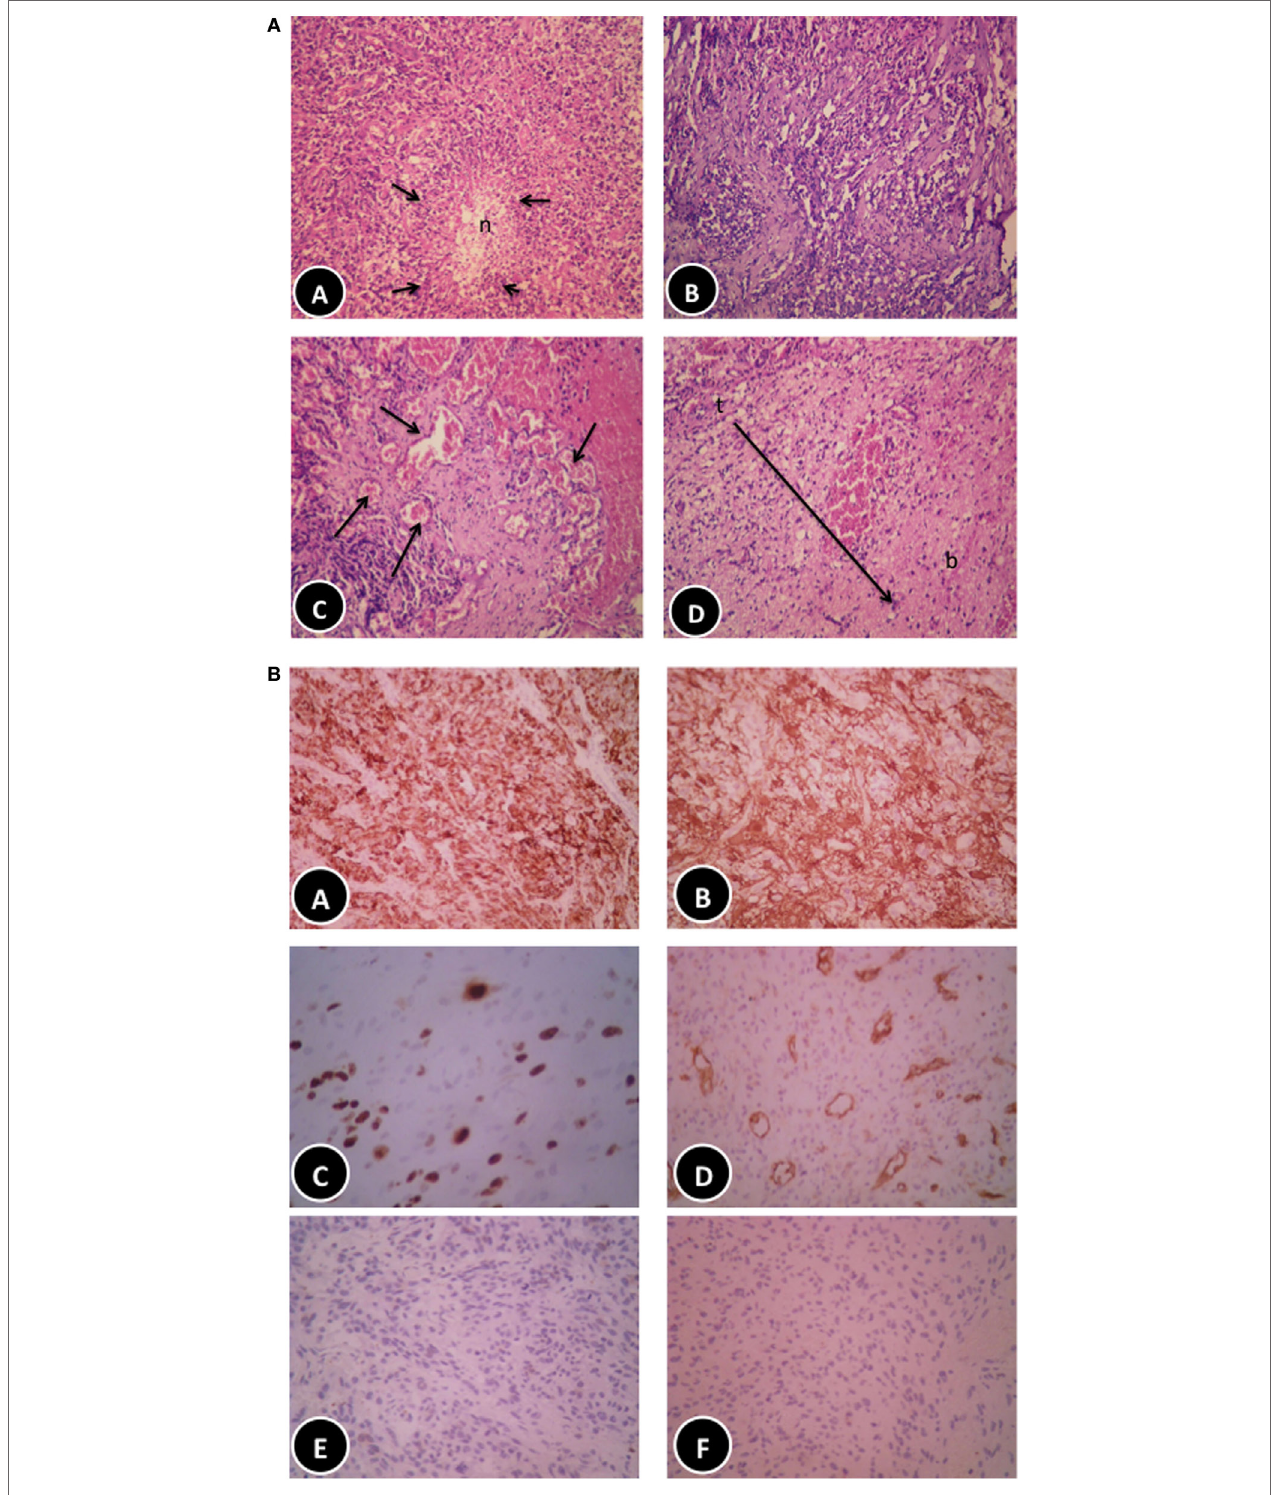
FiGURe 3 | (a) Histopathological features of the patient glioblastoma multiforme (GBM). (A) Classic GBM area with pseudopalisading necrosis. (B) Regressive changes in the form of variable background fibrosis. (C) Glomeruloid thick-walled blood vessels. (D) Tumor edge showing limited brain infiltration (haematoxylin and eosin, 200 × ). (B) Immunohistochemical features of the patient GBM. (A,B) Diffuse positive staining for glial fibrillary acidic protein (100 × and 200 × , respectively). (C) Moderately high proliferative activity (Ki67, 200 × ). (D) Numerous blood vessels highlighted by cluster of differentiation 31 immunostaining (100 × ), negative staining for epithelial markers: CK [(E) 200 × ] and epithelial membrane antigen [(F) 200 × ], respectively.